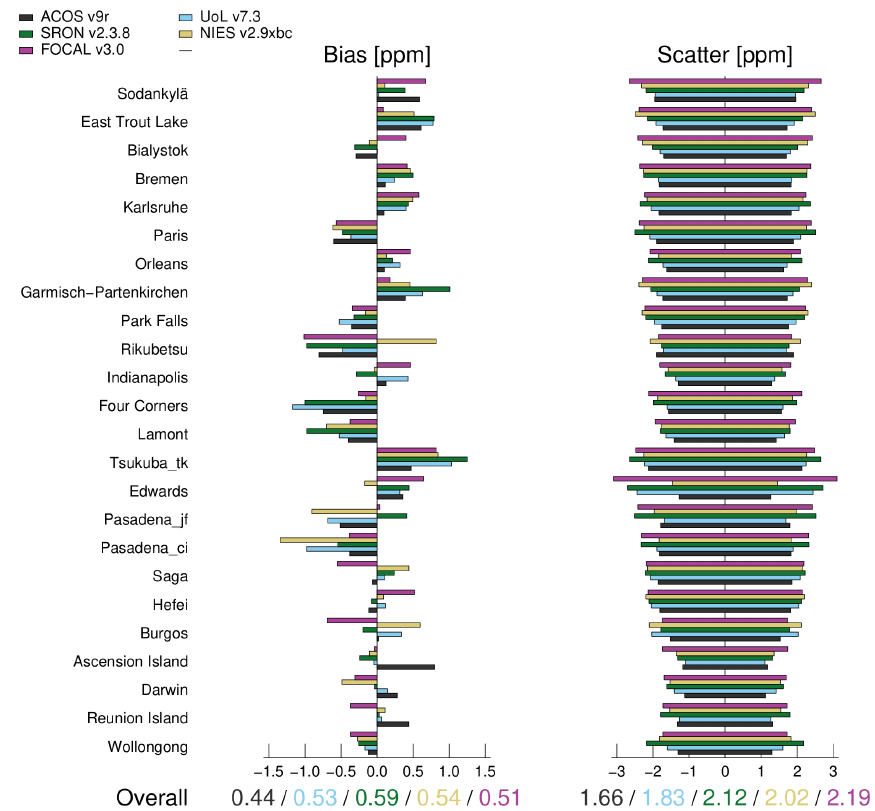
Figure 11. Overview of comparison results between different GOSAT XCO 2 products and TCCON data: scatter and bias for different TCCON stations. Note that the mean station bias has been subtracted to better illustrate the local station differences. See Table 6 for a summary of all TCCON validation